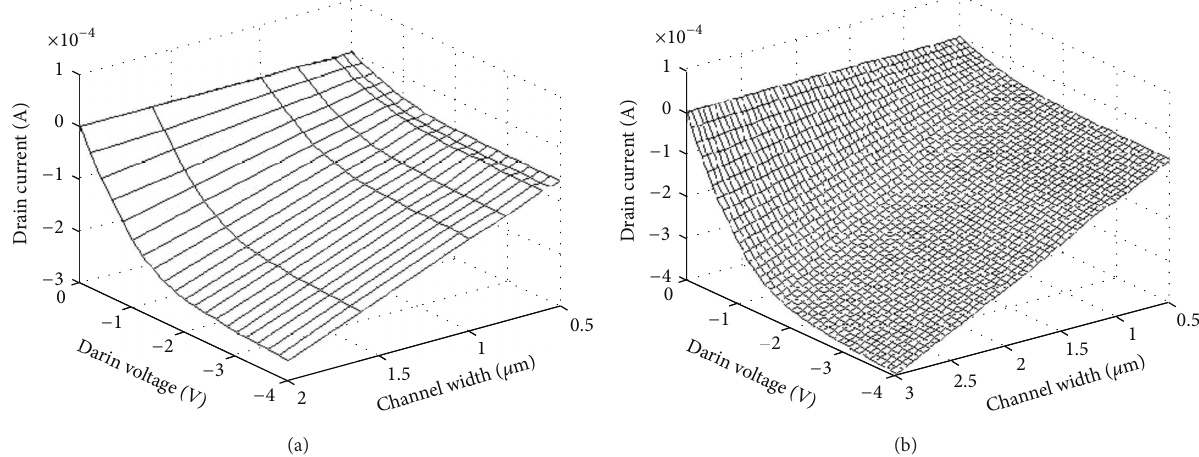
Figure 10: The 3D-like 𝐼 𝑑 (a) measurement data surface and (b) prediction data surface versus 𝑊 and 𝑉 𝑑 of the group 2A samples (as 𝑉 𝑔 = −3 V).